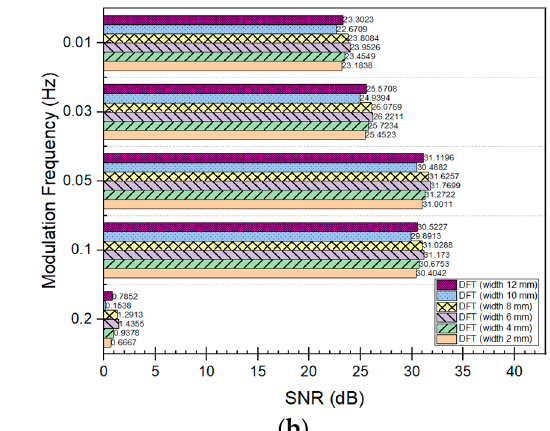
Figure 15. SNR value according to different defect length in sample group 2: ( a ) HA, ( b ) FFT.